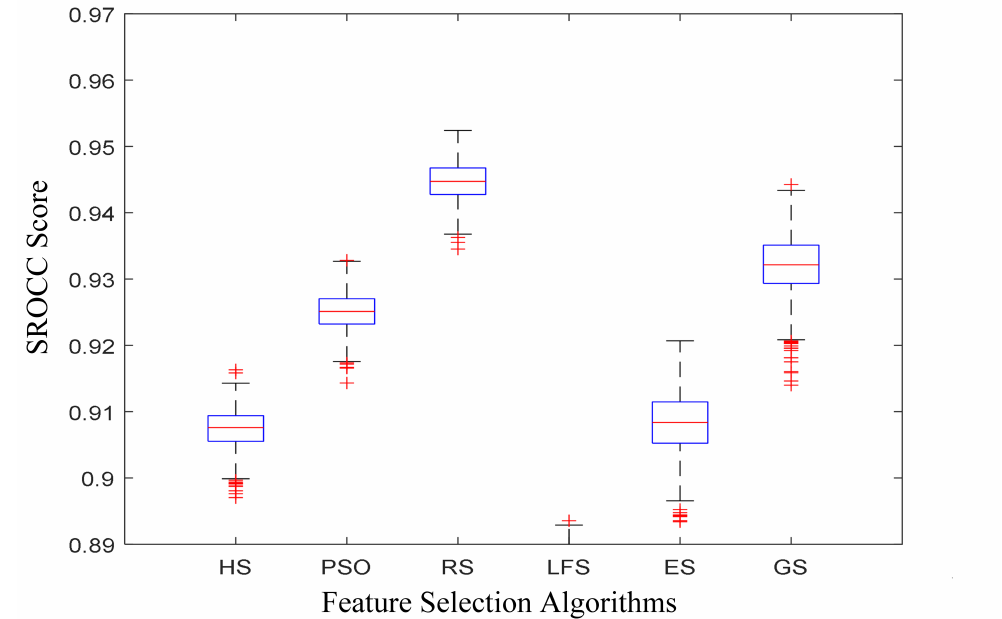
Figure 4. Box plots for the performance comparison in terms SROCC score between six feature selection algorithms for predicting battery